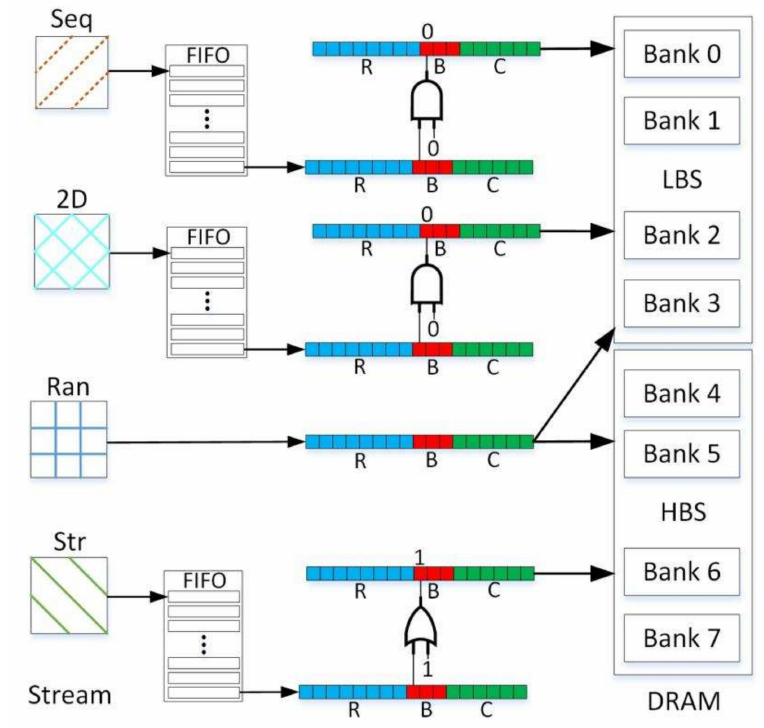
Figure 9. Bank retag operation